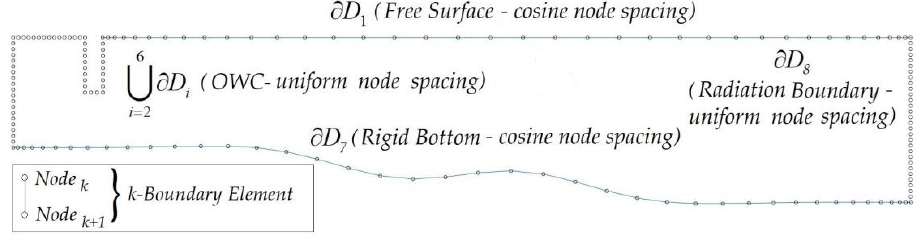
Figure 3. Generated mesh of an OWC in a non-uniform bathymetry domain.